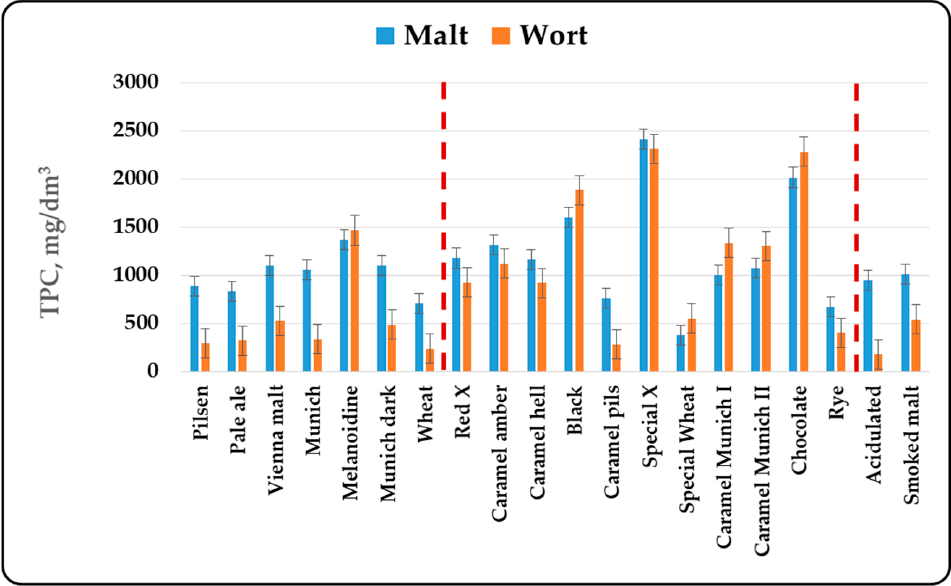
Figure 2. Total phenolic compounds in the different malt types, determined by the direct spectral method.